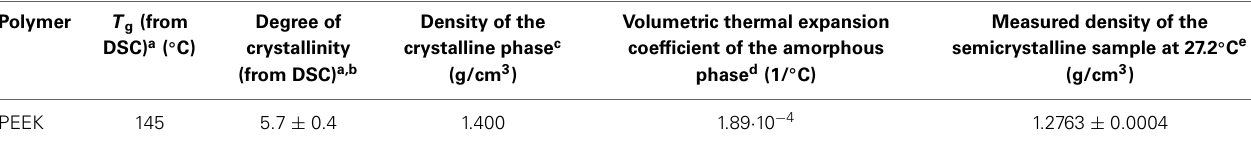
a From DSC measurement performed at a temperature scanning rate of 10 ◦ C/min. b Based on a theoretical melting enthalpy of 130(J/g) from Fougnies et al. (1997). c Taken from the literature (Mark, 1999). d Taken from the literature Lu et al. (1996). e Evaluated by